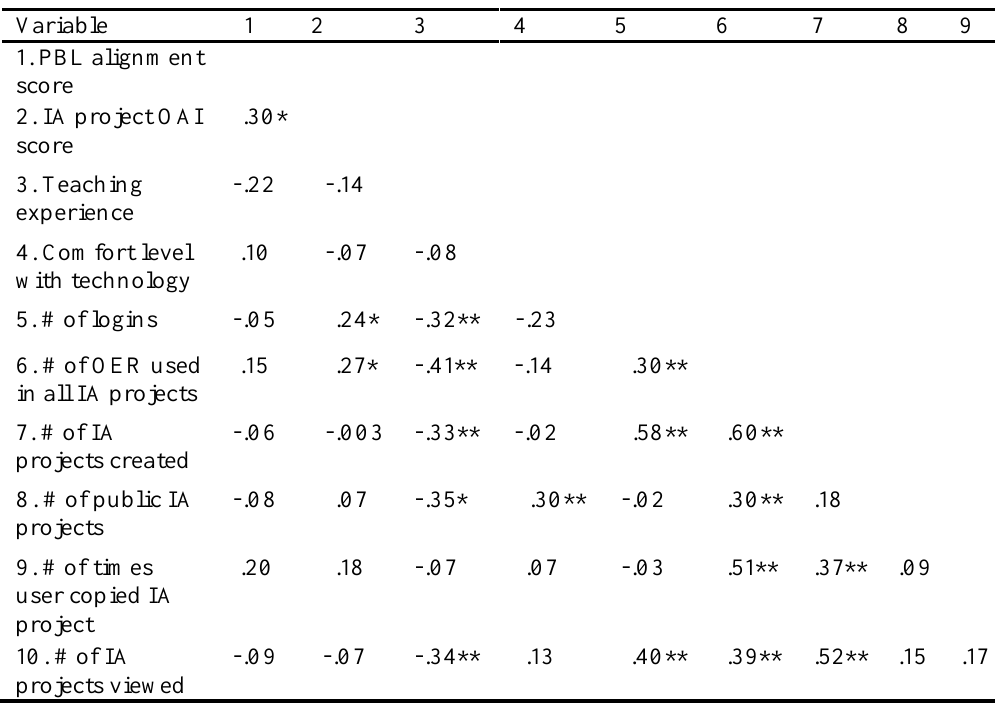
Table 7 Spearman’s Rank Correlations between PBL Alignment Score, OAI Score, and Characteristics of PD